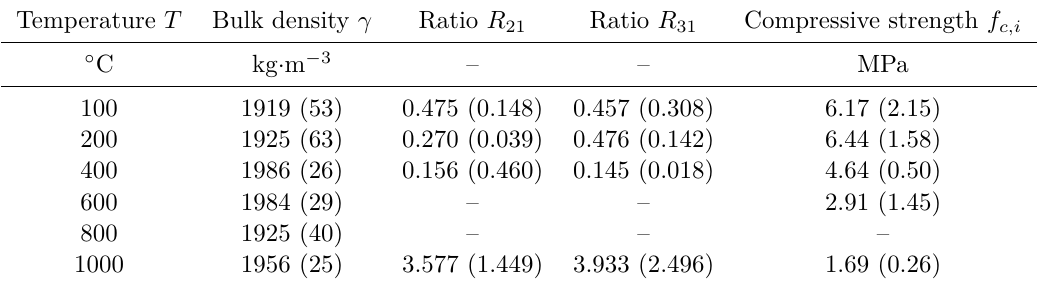
Table 2. Mean values (standard deviations) of selected